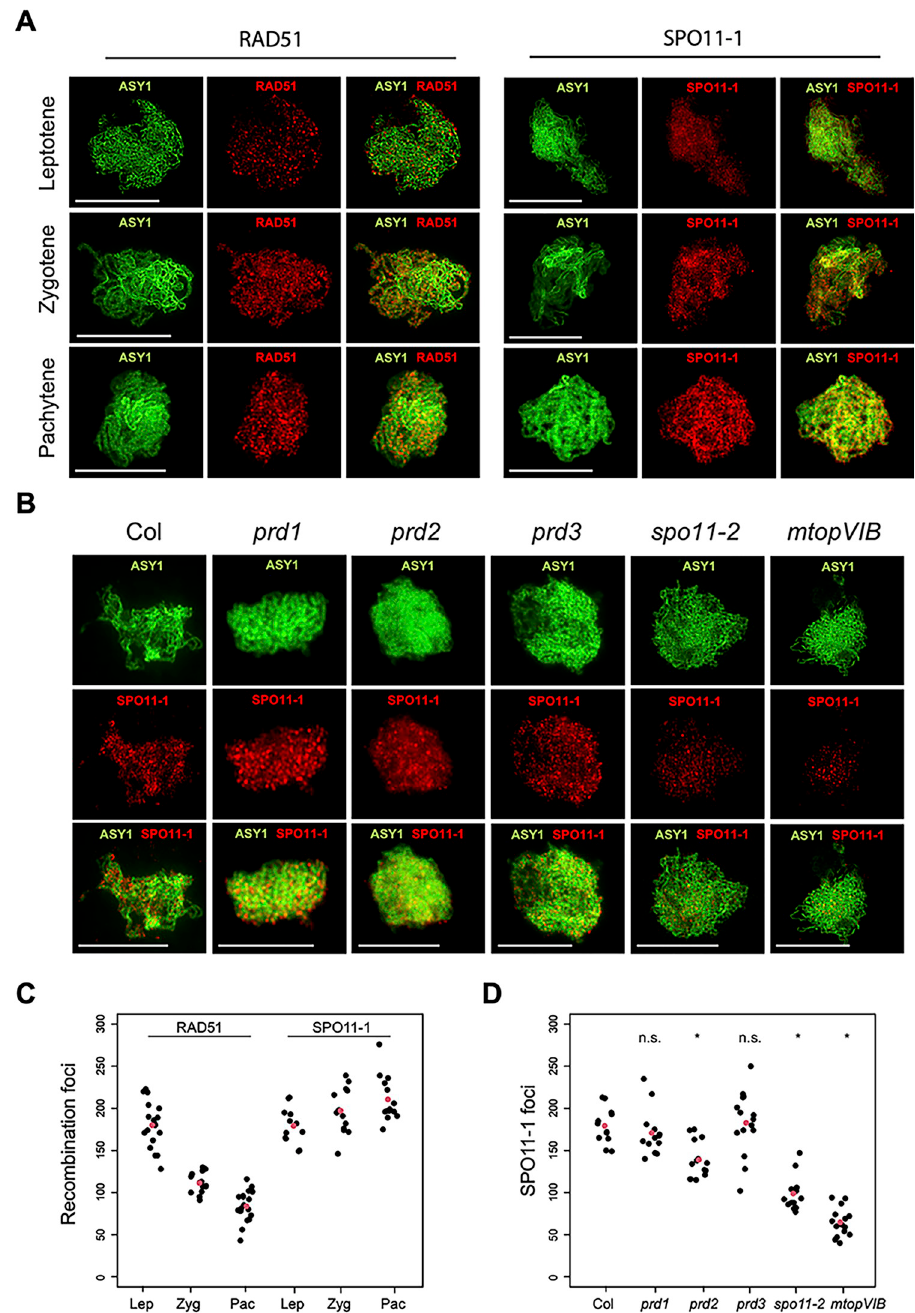
Fig 1. SPO11-1-MYC localisation in wild type and meiotic DSB defective mutants. ( A ) Localisation of RAD51 or SPO11-1-MYC (red) with ASY1 (green) on wild type (Col) male meiocytes, from leptotene to pachytene stages. Scale bars = 10 μ M. ( B ) Localisation of SPO11-1-MYC (red) and ASY1 (green) in wild type (Col), prd1 , prd2 , prd3 , spo11-2 and mtopVIb , during early prophase I. Scale bars = 10 μ M. ( C ) Plot showing RAD51 and SPO11-1-MYC foci counts in wild type (Col) at the leptotene (Lep), zygotene (Zyg) and pachytene (Pac) stages of meiosis. Black dots represent individual measurements, and red dots represent mean values. ( D ) Plot showing SPO11-1-MYC foci counts in wild type (Col) and DSB mutants in early prophase I. Black dots represent individual measurements, and red dots represent mean values. A Mann-Whitney-Wilcoxon test was used to compare SPO11-1-MYC foci count between wild type (Col) and mutants. “ � ” indicates a statistically significant difference. “n.s.” indicates a non-statistically significant difference.